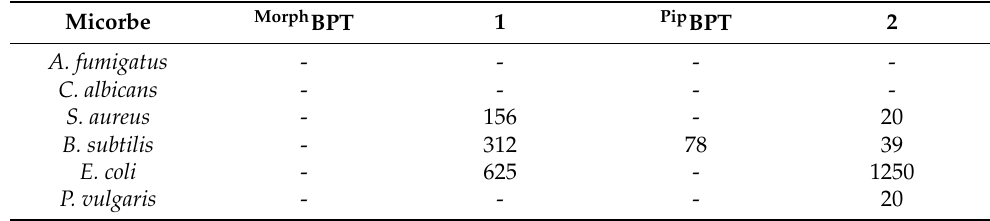
Table 6. MIC values ( µ g/mL) for the studied compounds.